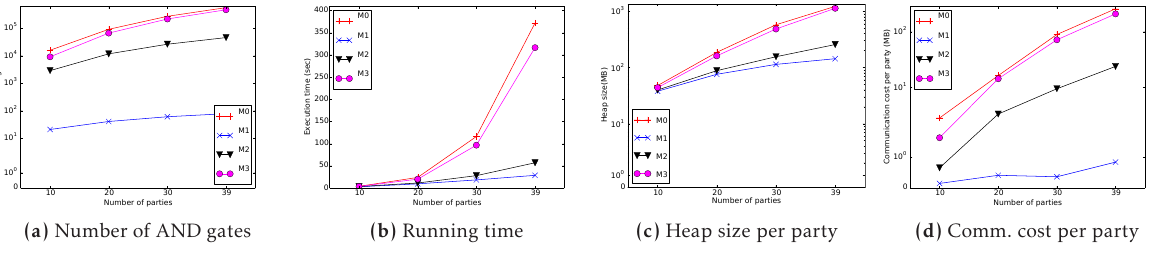
Figure 5. Performance of directory publication based on precomputation and